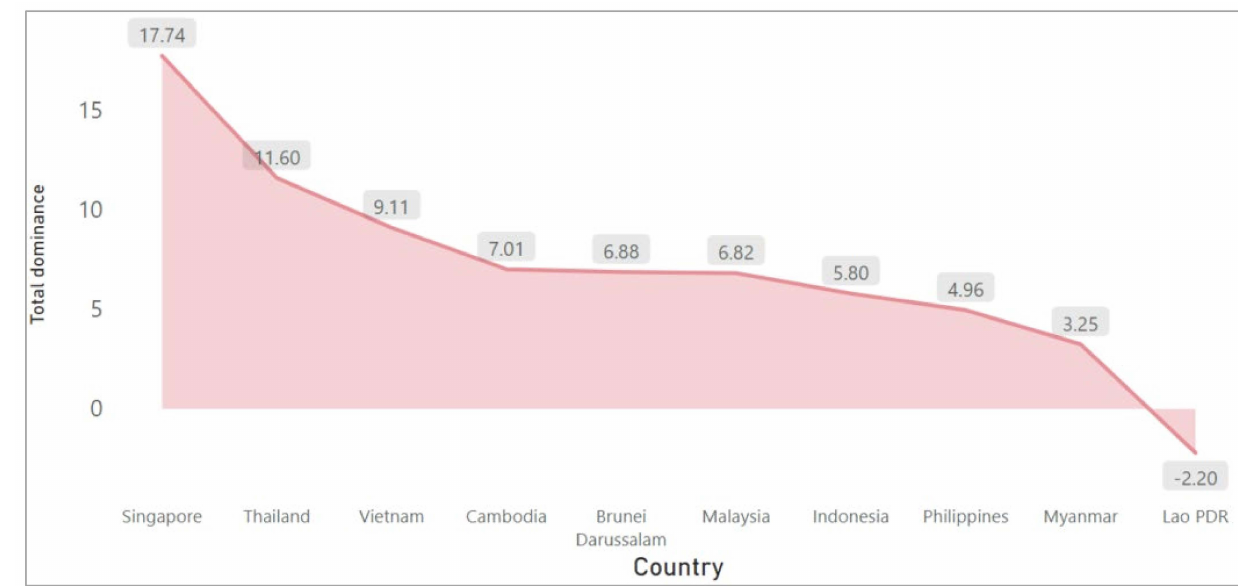
Figure 3. The total dominance of ASEAN countries.